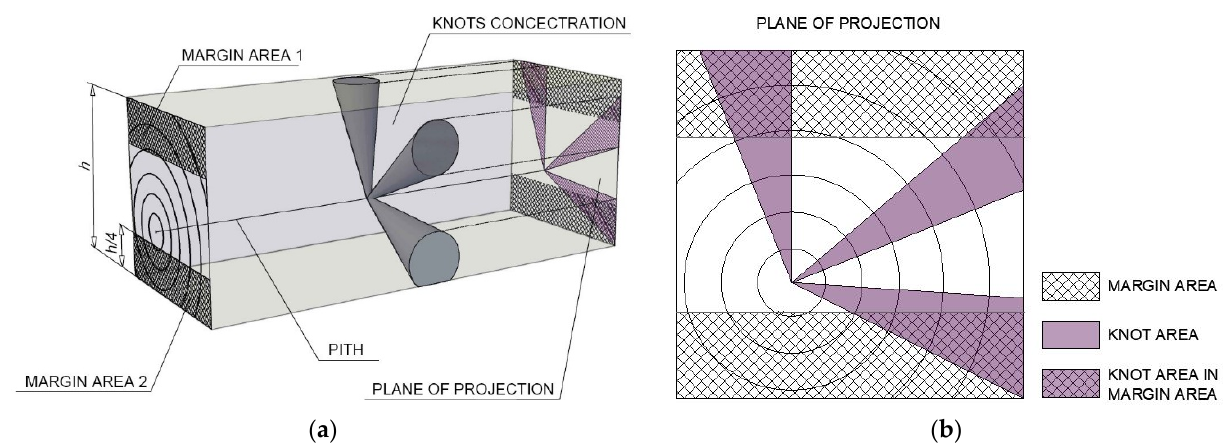
Figure 3. The principles of projecting knots with a division of marginal zones and determination of “worse margin”, based on Reference [44]: ( a ) a spatial view and ( b ) details of the plane of projection.